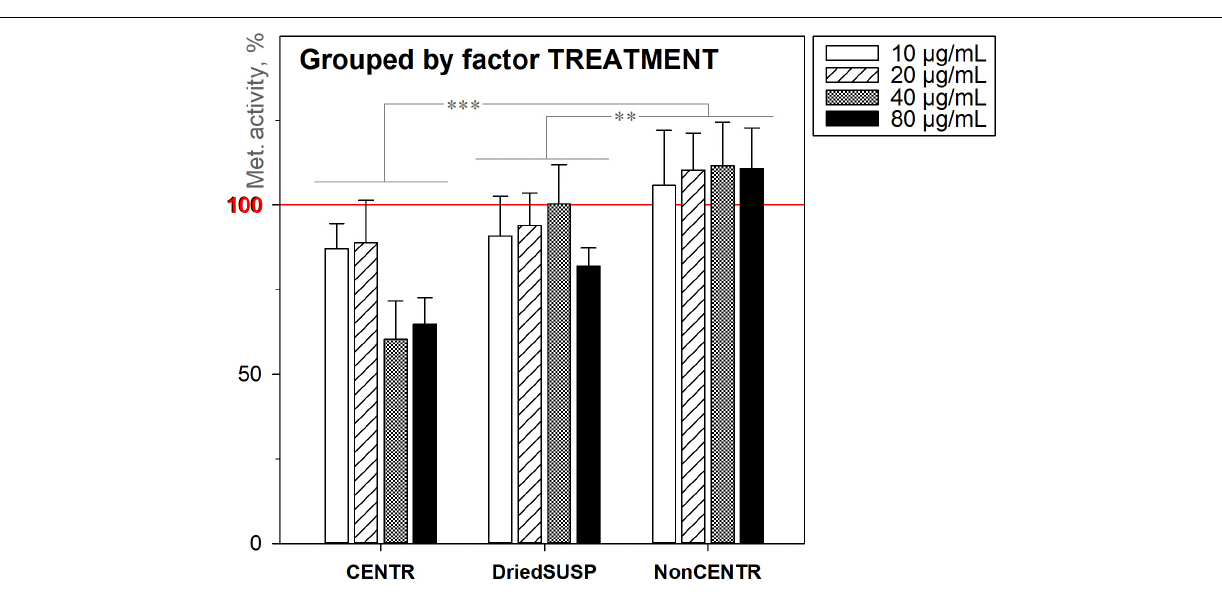
FIGURE 9 | Metabolic activity of HDFs cultured with DND for 72 h under three deposition methods, using the alamarBlueTM assay (normalised to the non-treated cells; n = 4; ∗∗∗ p < 0.001; ∗∗ p < 0.01; ∗ p < 0.05; ±